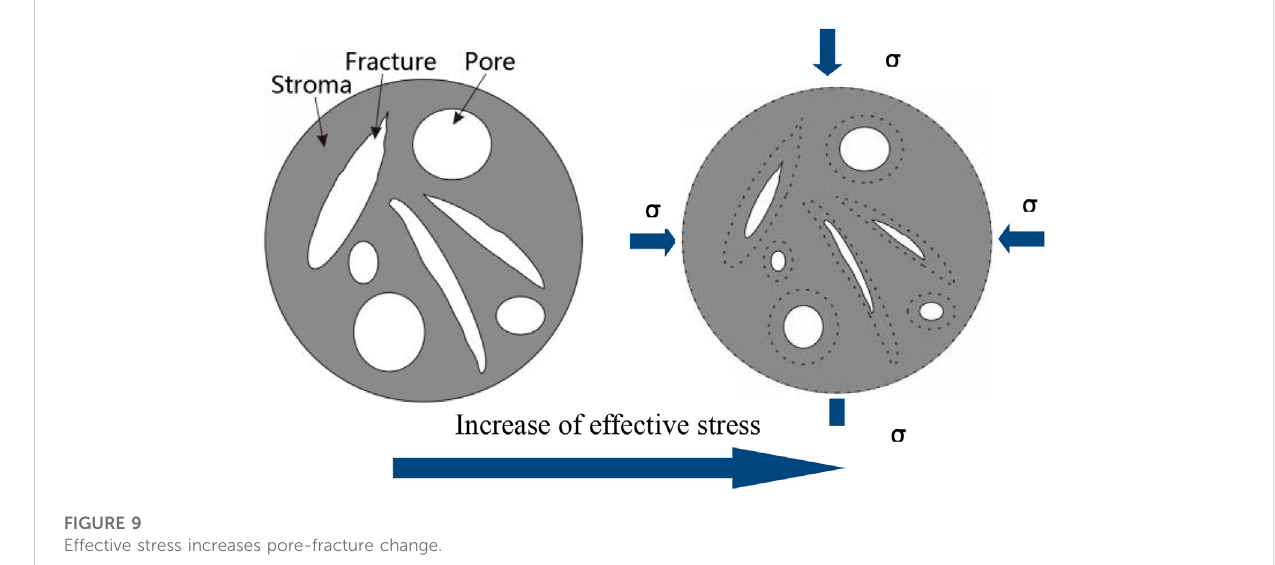
FIGURE 9 Effective stress increases pore-fracture change.